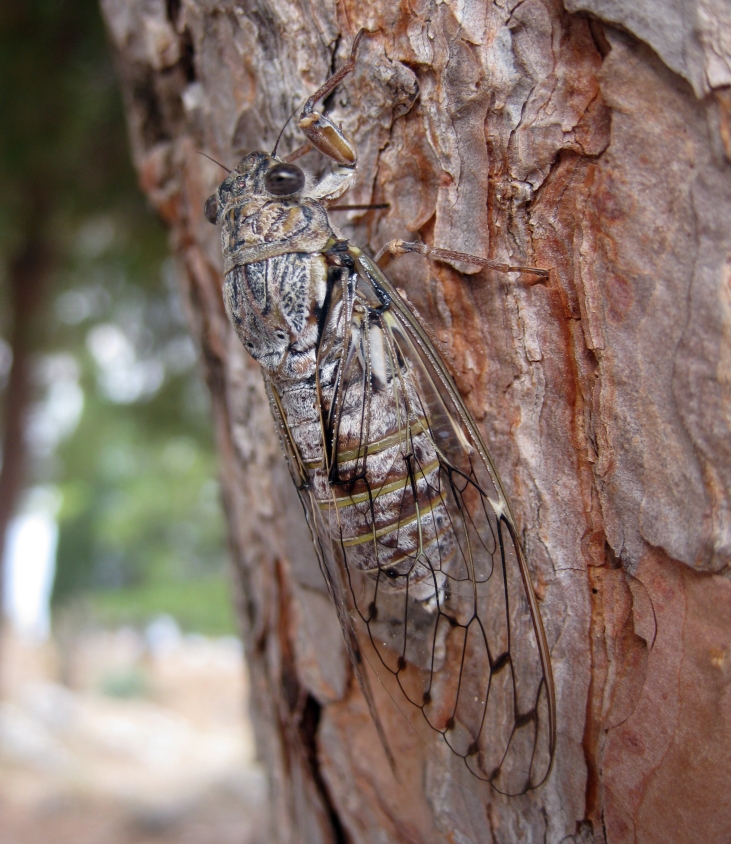

Cicada
orni male.